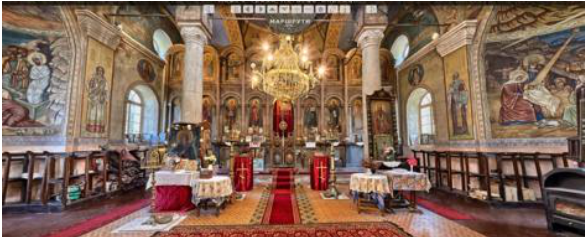
Figure 5. 3D visualization based on spherical panoramic images –